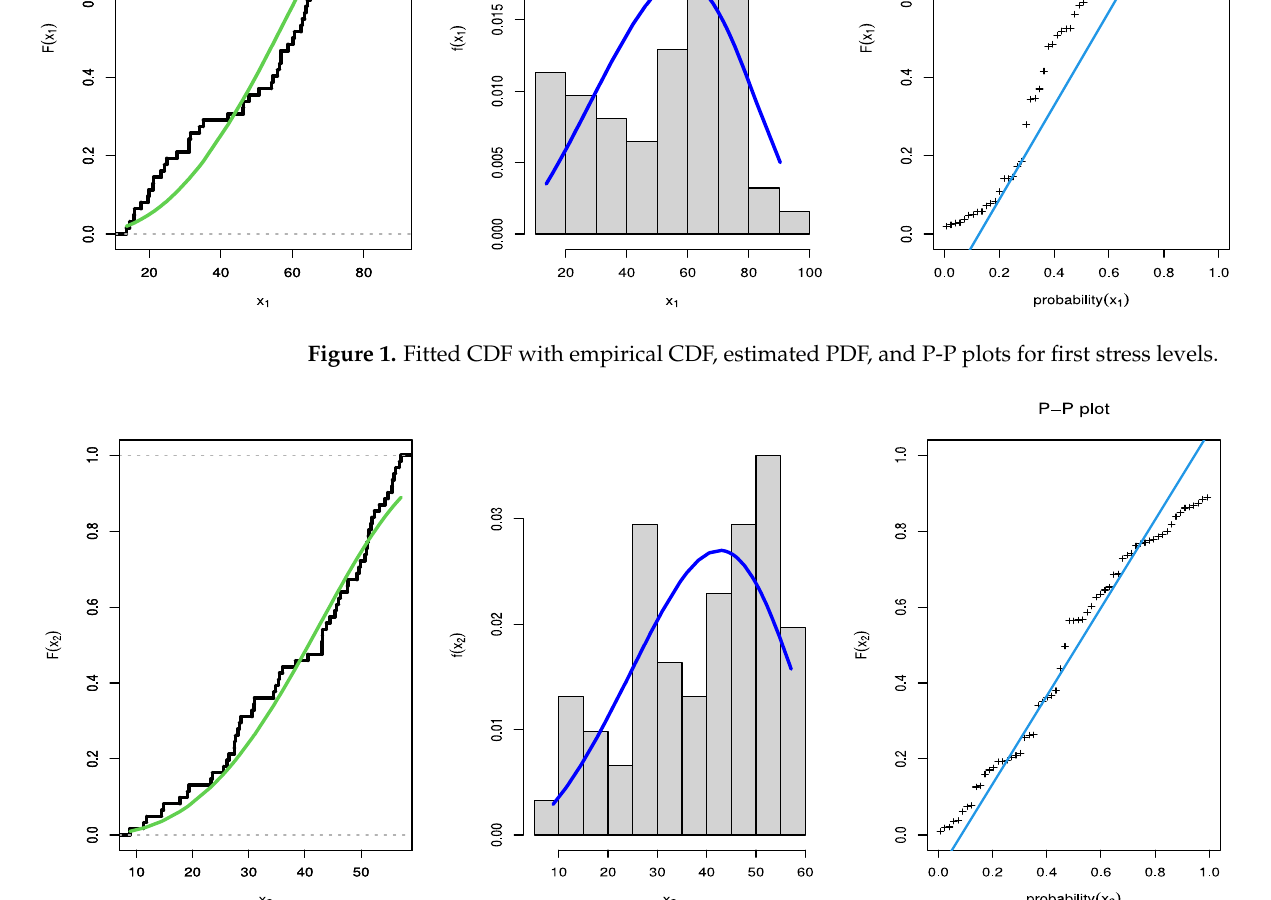
Figure 2. Fitted CDF with empirical CDF, estimated PDF, and P-P plots for second stress levels.